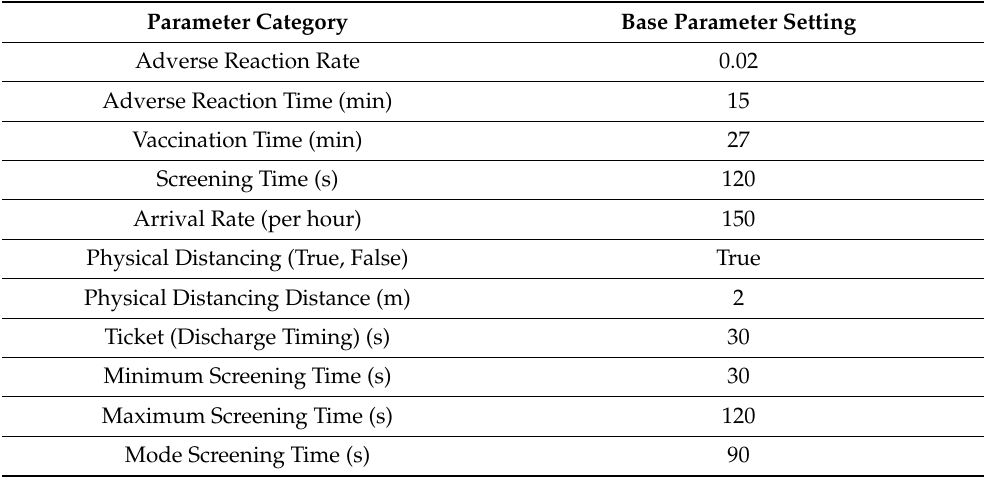
Table 1. Parameter categories that determine the conditions of the simulation and the corresponding parameter settings of the base